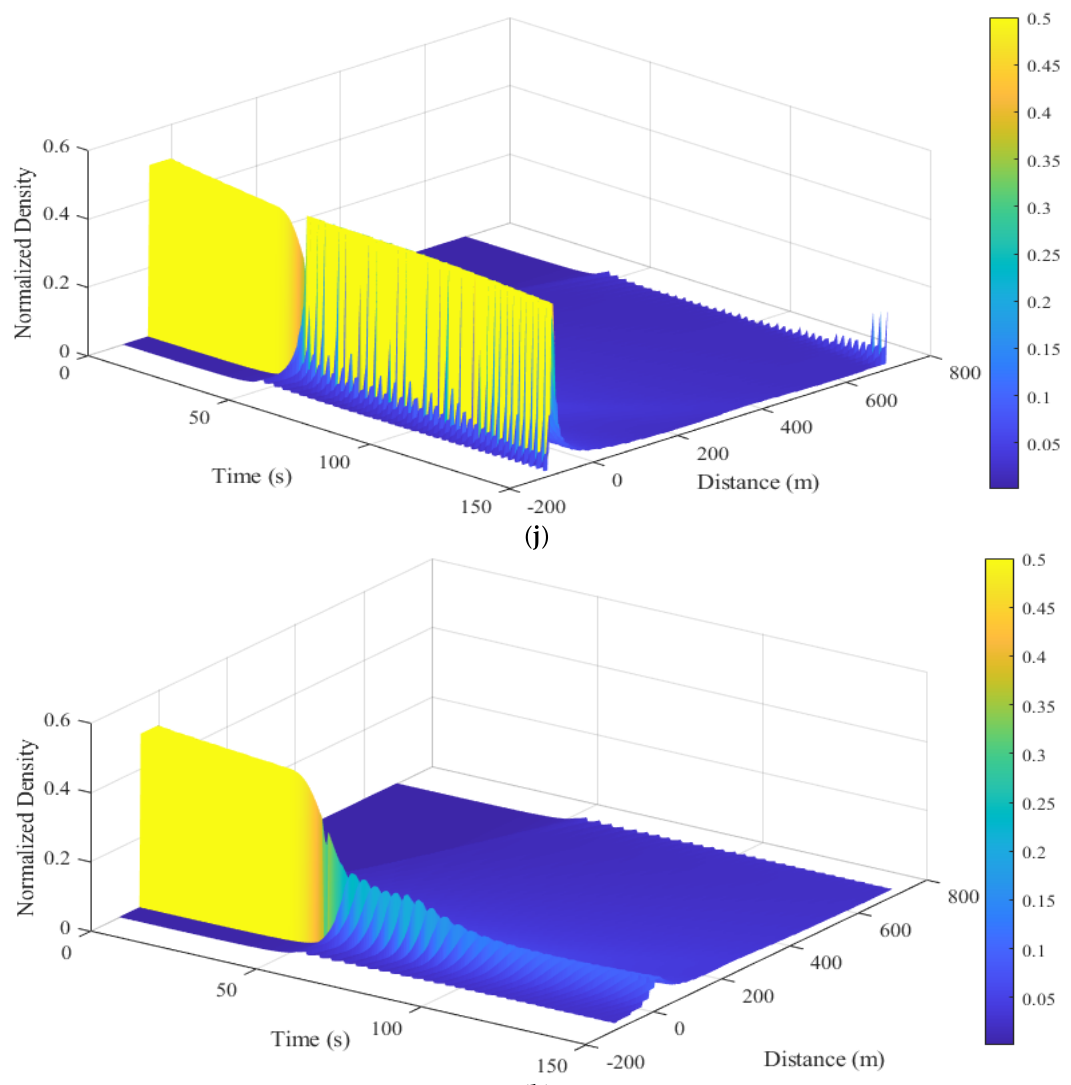
Figure 8. Traffic density behavior of the ID and proposed models over an 800 m circular road: ( a ) ID model, 𝛿 = 1 ; ( b ) ID model, 𝛿 = 4 ; ( c ) ID model, 𝛿 = 20 ; ( d ) proposed model, 𝛼 = 0 ; ( e ) proposed model, 𝛼 = 0.3 ; ( f ) proposed model, 𝛼 = 0.55 ; ( g ) proposed model, 𝛼 = 0.7 ; ( h ) proposed model, 𝛼 = 0.8 ; ( i ) proposed model, 𝛼 = 0.9 ; ( j ) proposed model for a platoon of 30 vehicles, 𝛼 = 0 ; ( k ) proposed model for a platoon of 30 vehicles, 𝛼 = 0.9 .